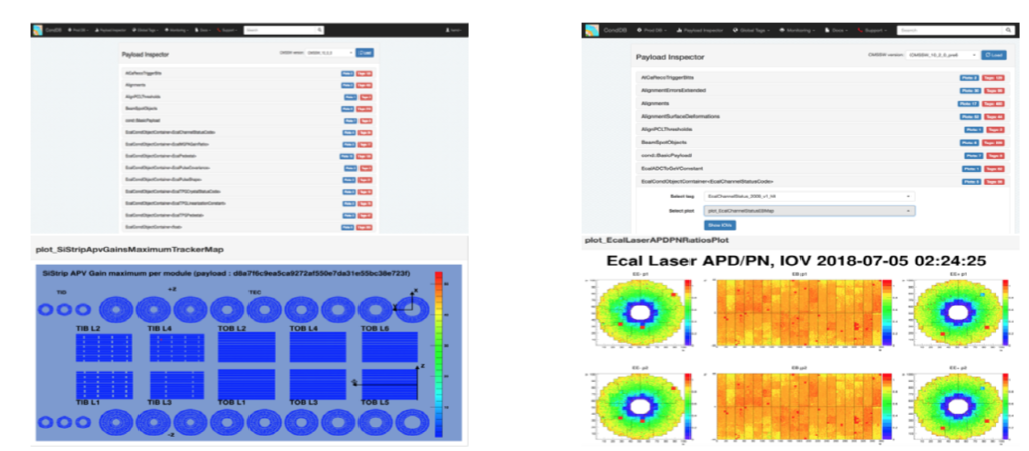
Figure 3. Data Visualisation using Payload